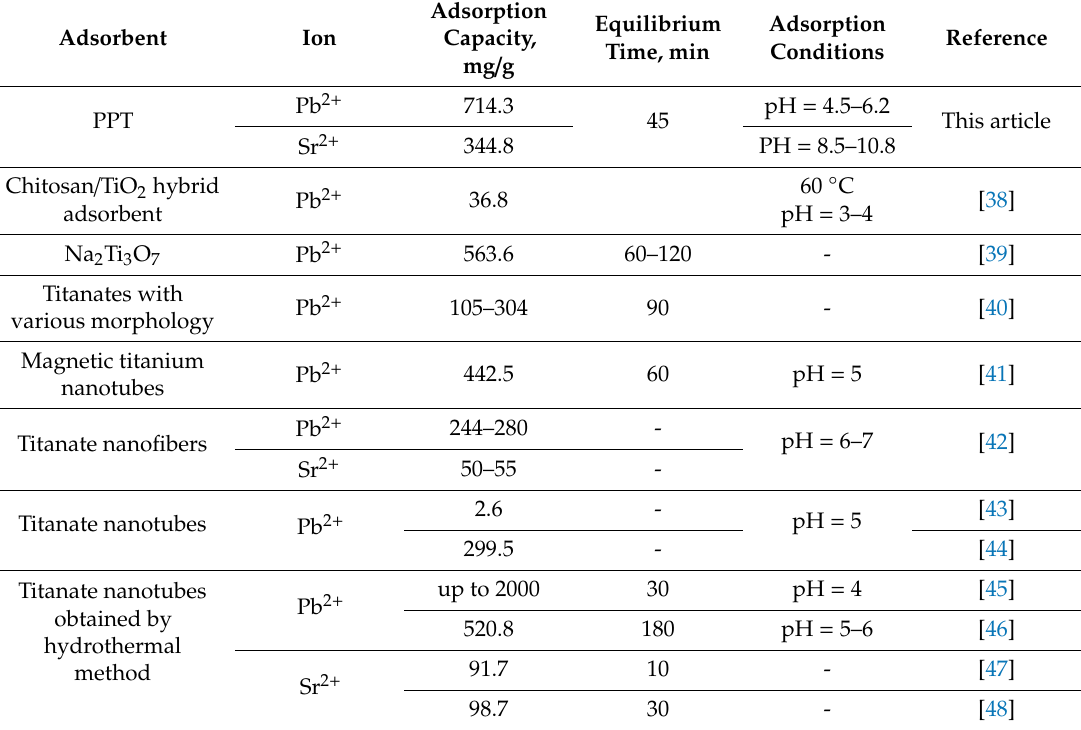
Table 3. Reported adsorption capacities towards heavy metal ions by typical